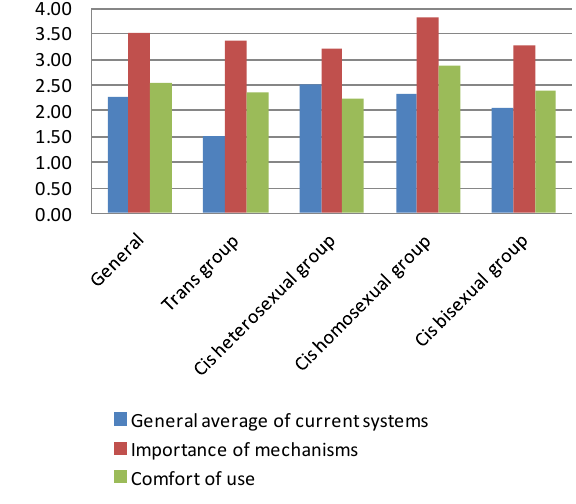
Fig. 11 – Average of grades given by each group Trans population gave a lower general grade, albeit it was not the group who gave greater importance to the